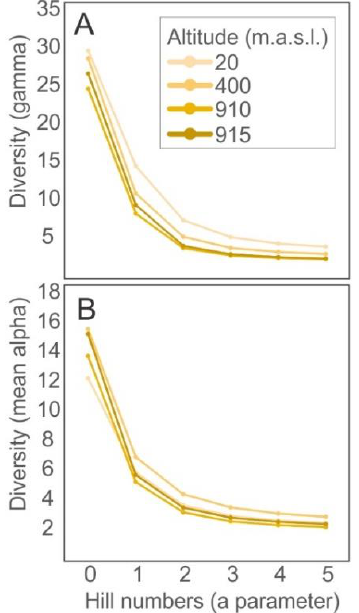
Figure 4. Diversity profiles built with the Hill series of eukaryotic communities present in bromeliad cisterns at four di ff erent altitudes. Data summarized according to the spatial component of diversity: altitude level, or gamma component ( A ) and cistern level, showing mean values for the alpha component ( B ). Table 4. Spatial components of the diversity of eukaryotic communities present in bromeliad cisterns in four di ff erent altitudes. Alpha (cistern level; mean values ± standard deviation) and gamma (pooled to the altitude level) diversities were calculated with Gini-Simpson diversity index. Beta diversity calculated with Sørensen dissimilarity index. Beta diversity components (turnover and nestedness) are expressed as raw values and proportional contribution (%).